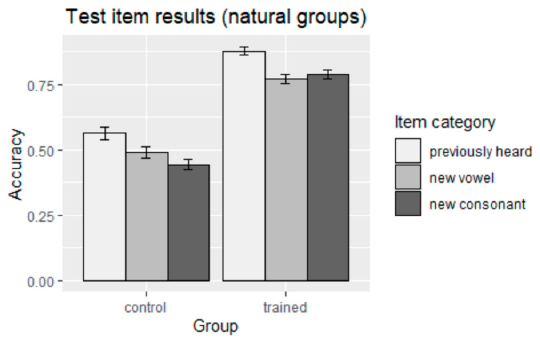
Figure 3. Accuracy of responses to test items (natural